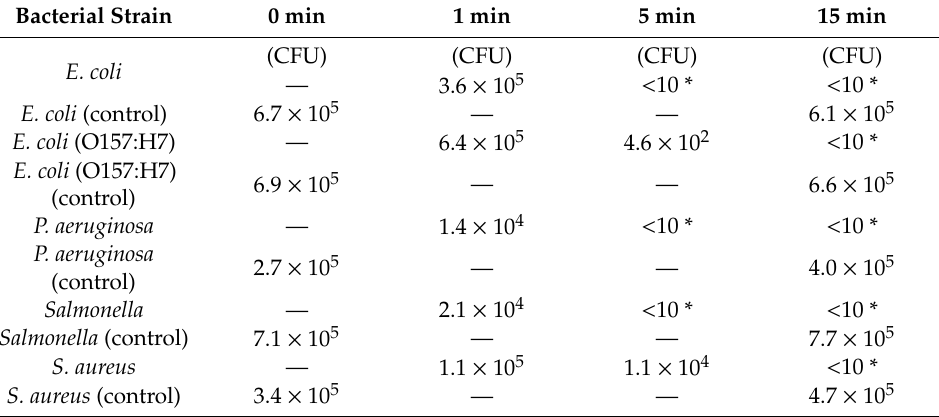
Table 1. Assay of the activity of BiSCaO Water against pathogenic microbes in vitro. Bacterial Strain